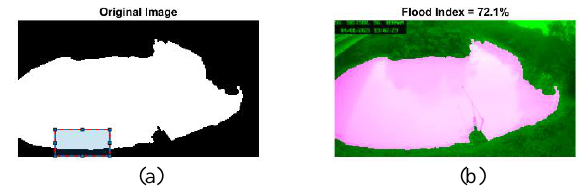
Figure 4 . The flood index for the image of 4th of August 2021. (a) The ROI contains more white pixels than black. (b) The flood index computed was 72.1%.